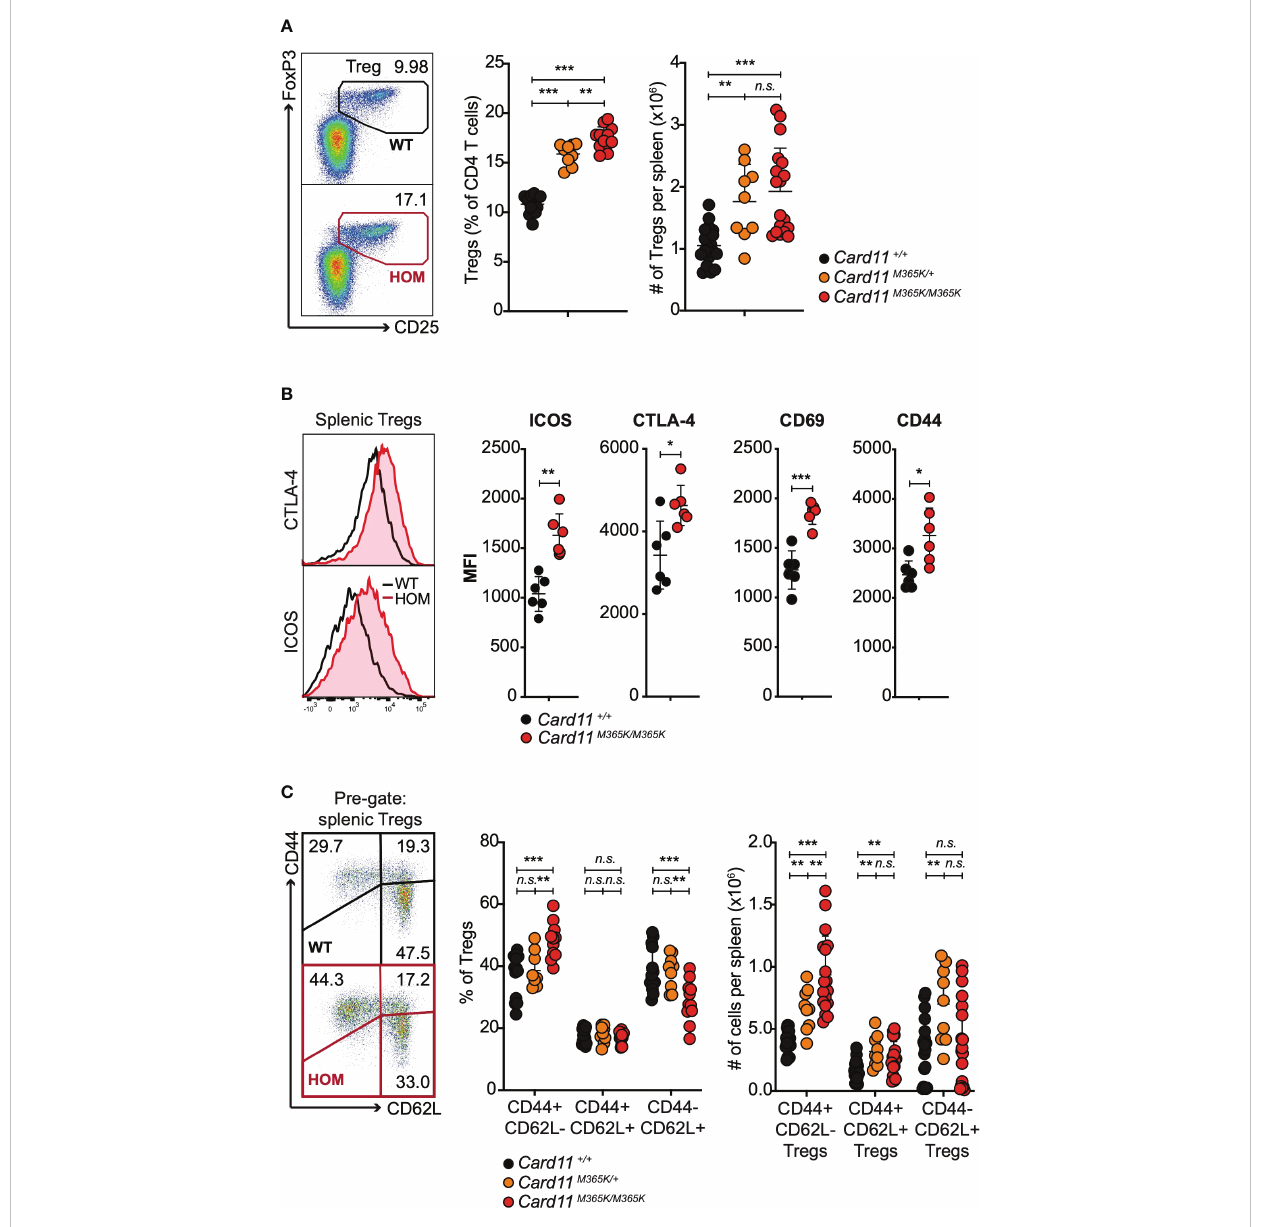
FIGURE 3 Germline GOF Card11 M365K mutation causes accumulation of CD62L neg CD44 high ICOS high CTLA-4 high T regulatory cells. (A) . Left, representative fl ow cytometric analysis and right, percentage amongst CD4 T cells or total number per spleen of TCR b + CD4 + CD25 + FoxP3 + T regulatory (T REG ) cells, in mice of the indicated genotypes. (B) . Left, representative fl ow cytometric histograms showing distribution of intracellular CTLA-4 and cell-surface ICOS fl uorescence and right, plots of mean fl uorescence intensity (MFI) of ICOS, CTLA-4, CD69 or CD44, for splenic T REGS from mice of the indicated genotypes. (C) Left, representative fl ow cytometric analysis and right, percentage amongst T REGS or total number per spleen of CD44